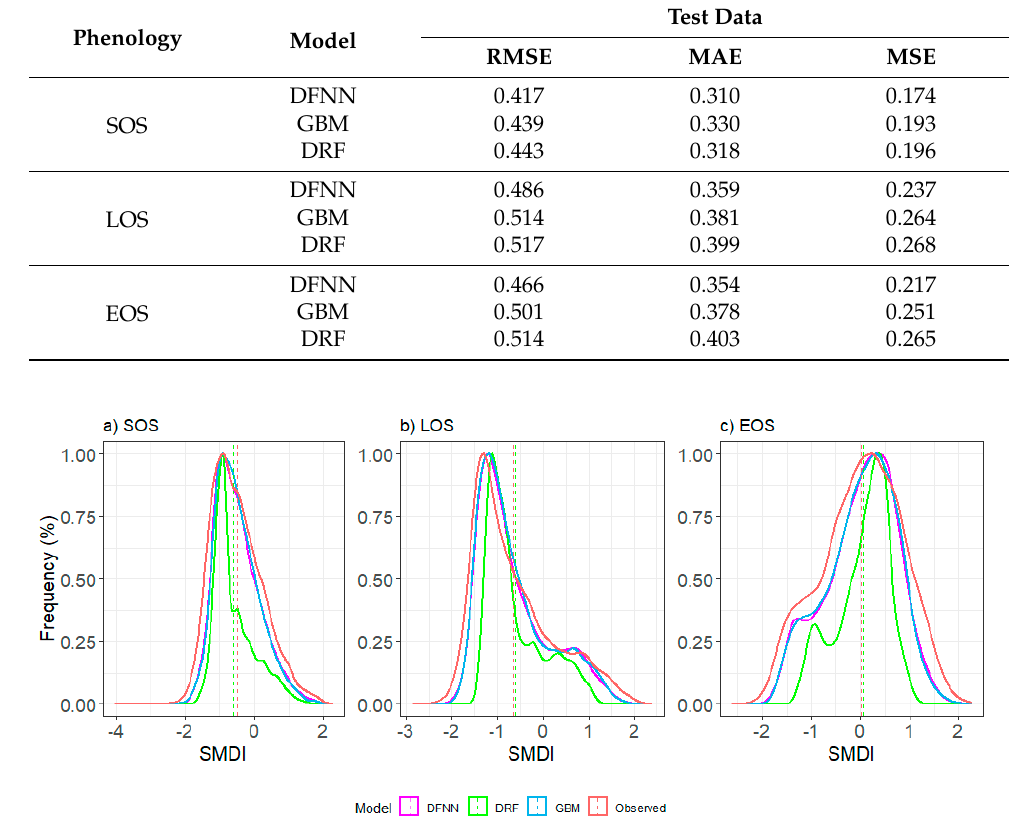
Table 5. Comparison of the performance of deep learning and machine learning model on the test data set for the prediction of SMDI.